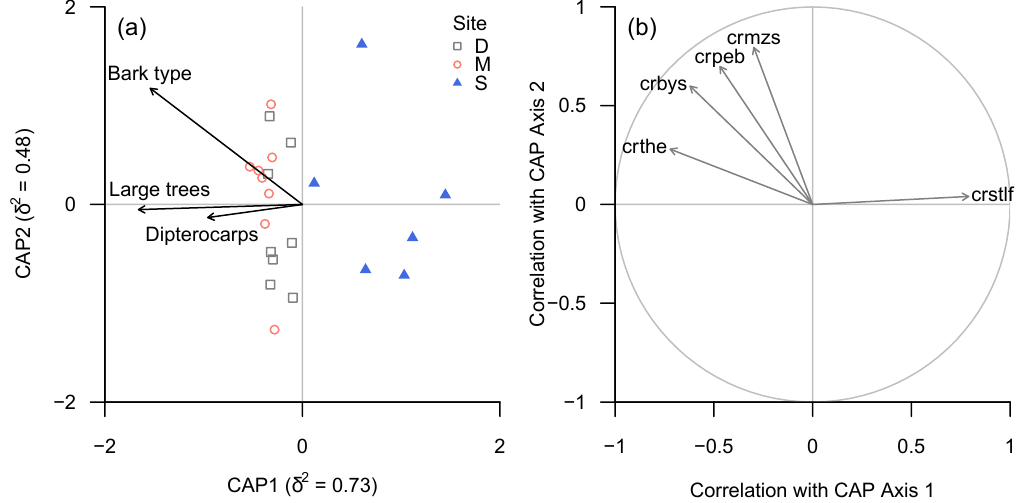
Figure 6. ( a ) CAP ordination plot of lichen community structure (functional groups) according to continuous environmental (tree trait) variables, based on ‘plot-level’ data summarised for each plot. ( b ) Spearman rank correlation coefficients between CAP axes and individual functional groups for which | ρ | ≥ 0.6. Functional groups in ( b ): crbys—crustose byssoid sterile, crmzs—crustose mazaedioid, crpeb—crustose perithecia melanised, crstlf—crustose sterile no cortex, prothallus